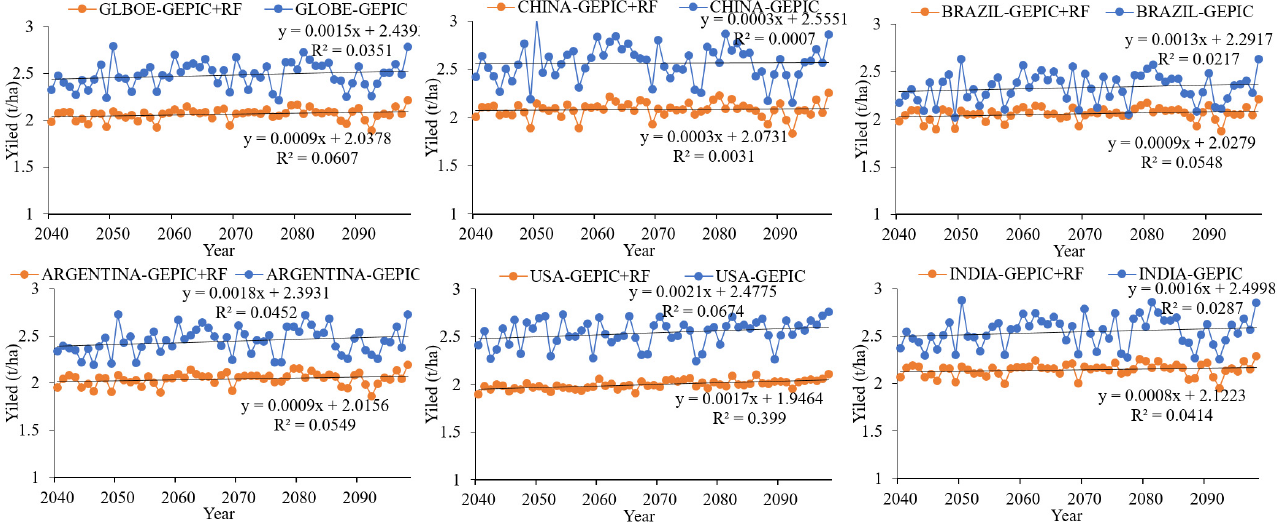
Figure 6. Future projections of soybean yield from the GEPIC model and GEPIC+RF model for 2040 to 2099. The black lines are linear trend line.